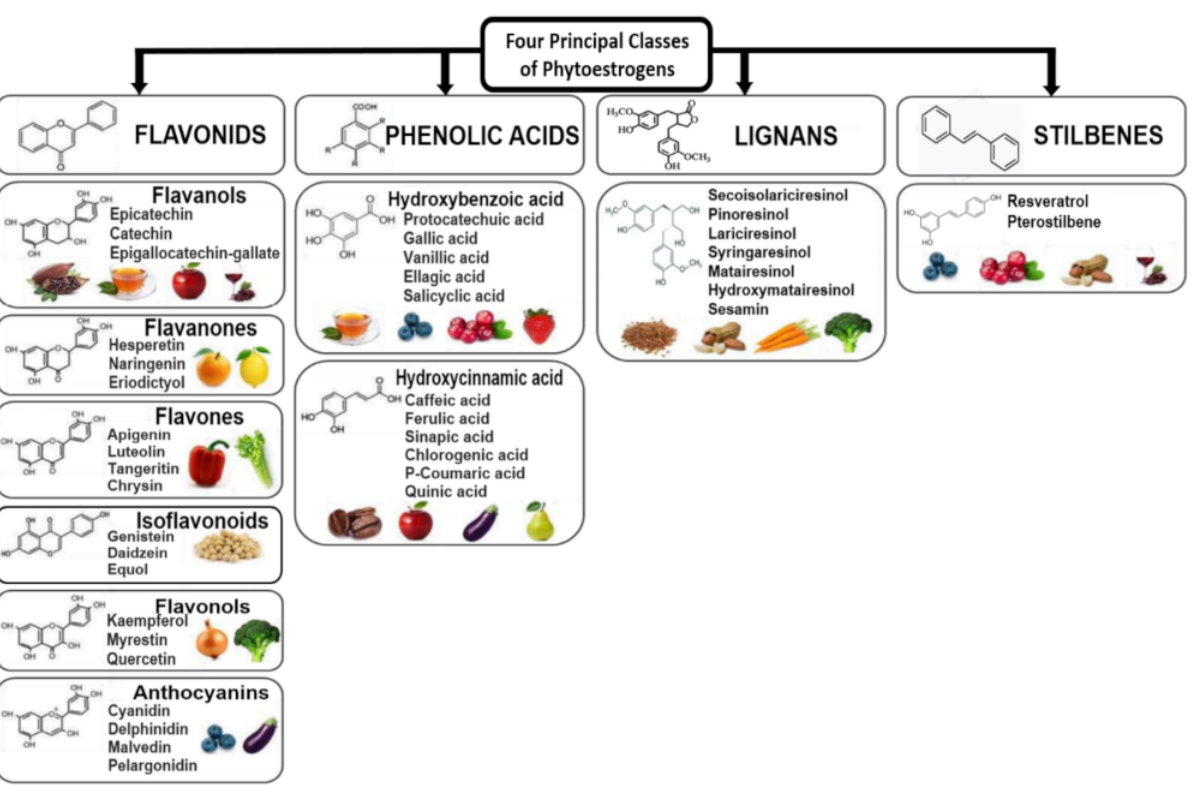
Figure 5. Four principal classes of phytoestrogens, the various subclasses, examples of chemical structures, chemical names and pictures of food products that contain these polyphenolic/phytoestrogens compounds [53] (use and modified with permission for BenthamScience ID # 600053254 and IN